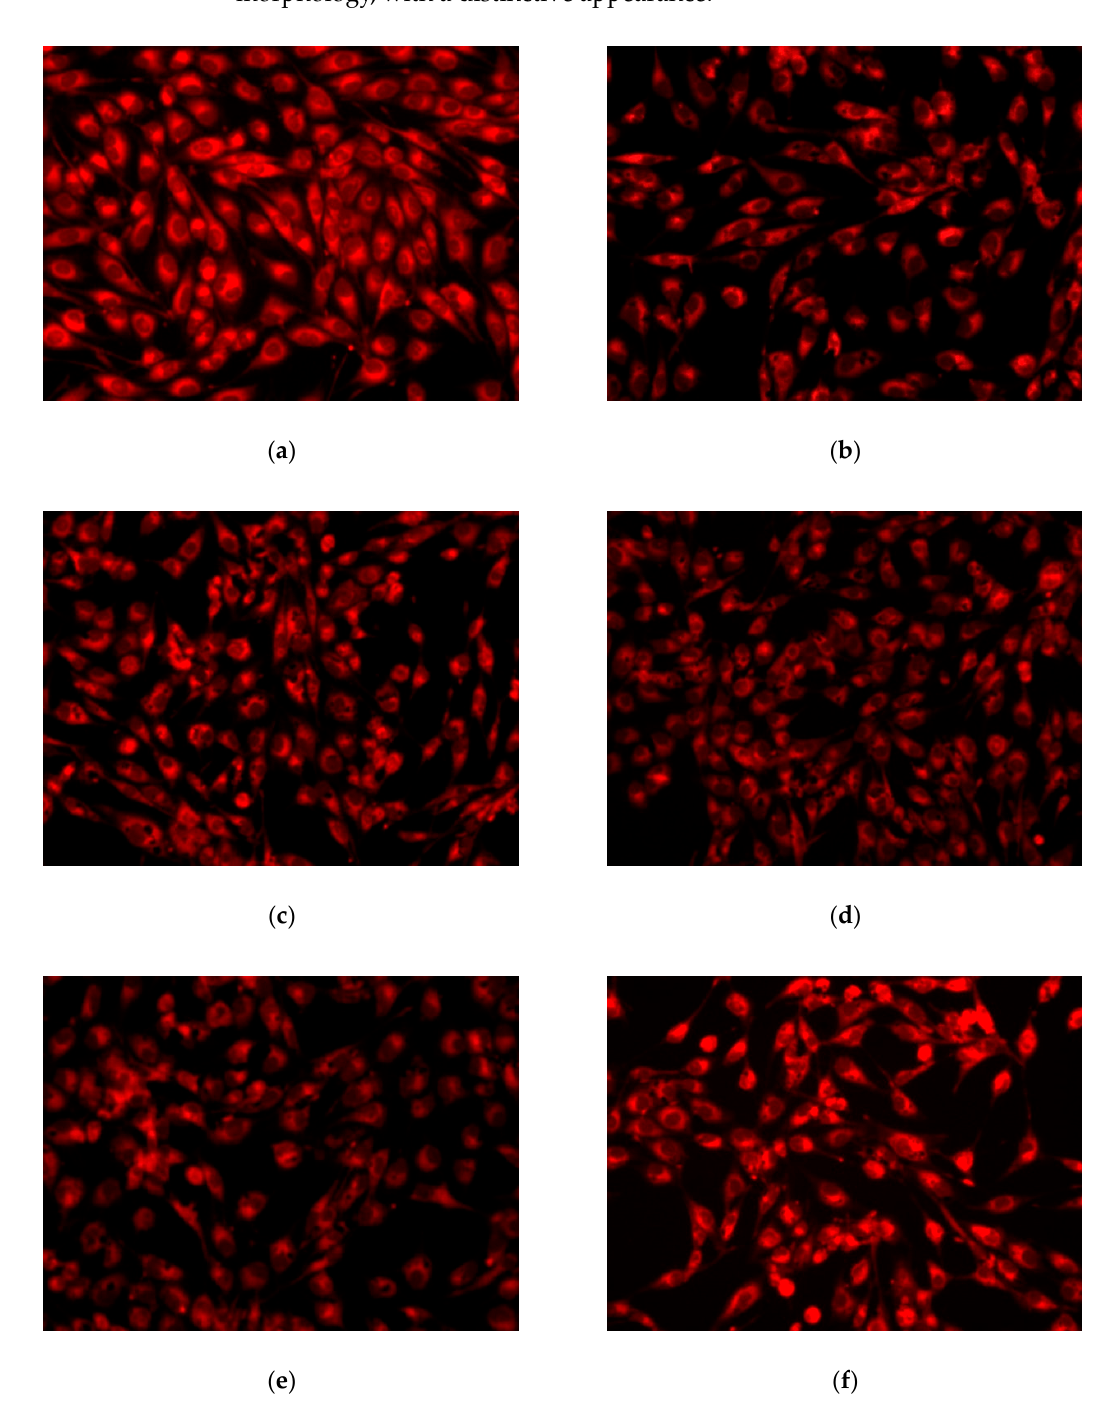
Figure 11. Fluorescence images of Ca 10 − x Tb x (PO 4 ) 6 (OH) 2 samples colored with CMTPX fluorophore: ( a ) control sample; ( b ) x = 0.05; ( c ) x = 0.1; ( d ) x = 0.25; ( e ) x = 0.5; ( f ) x = 1.